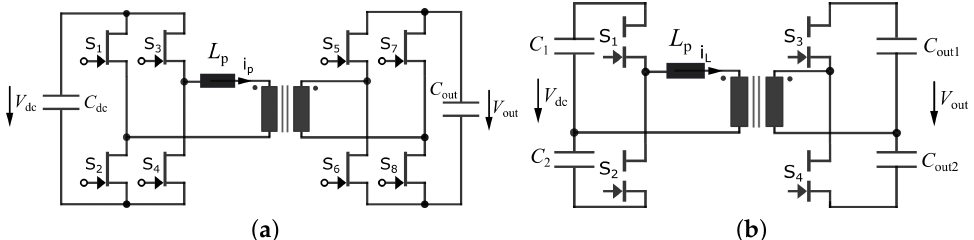
Figure 19. ( a ) Dual active bridge (DAB) converter, ( b ) dual active half-bridge (DAHB) converter proposed by [139].